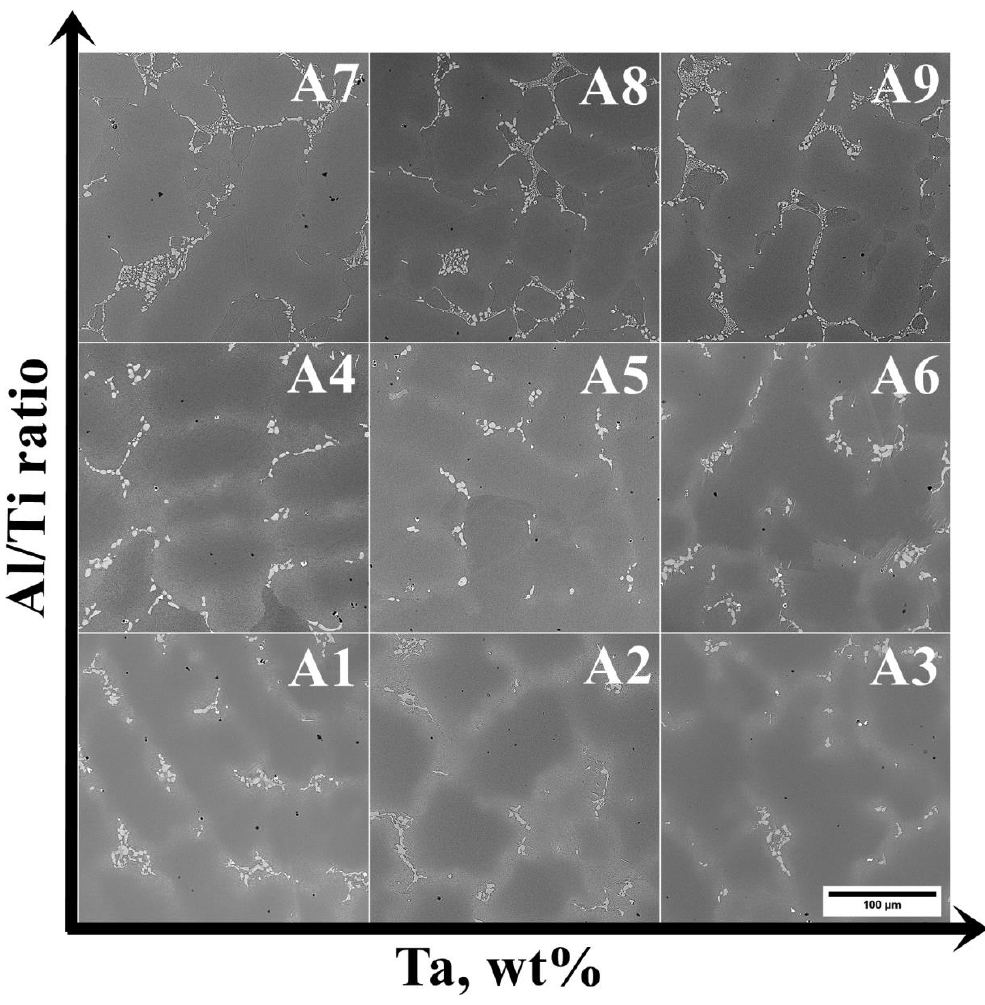
Figure 4. Dendritic structure of the as-cast (A1 – A9) superalloys, SEM-BSE.